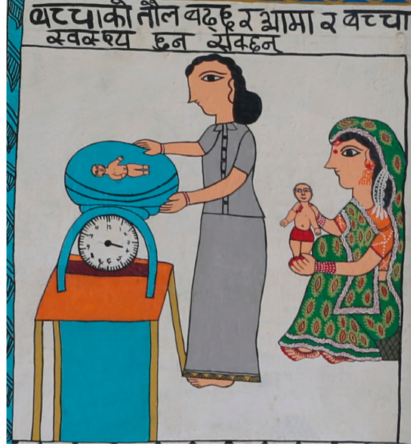
Figure 4. The health concerns in children. Translation: Figure 4 = “Baby’s weight increases and mother and baby may become healthy”. The picture shows a mother taking her child to be weighed by a health professional. It illustrates both her concern and also how weight can improve without exposure to air